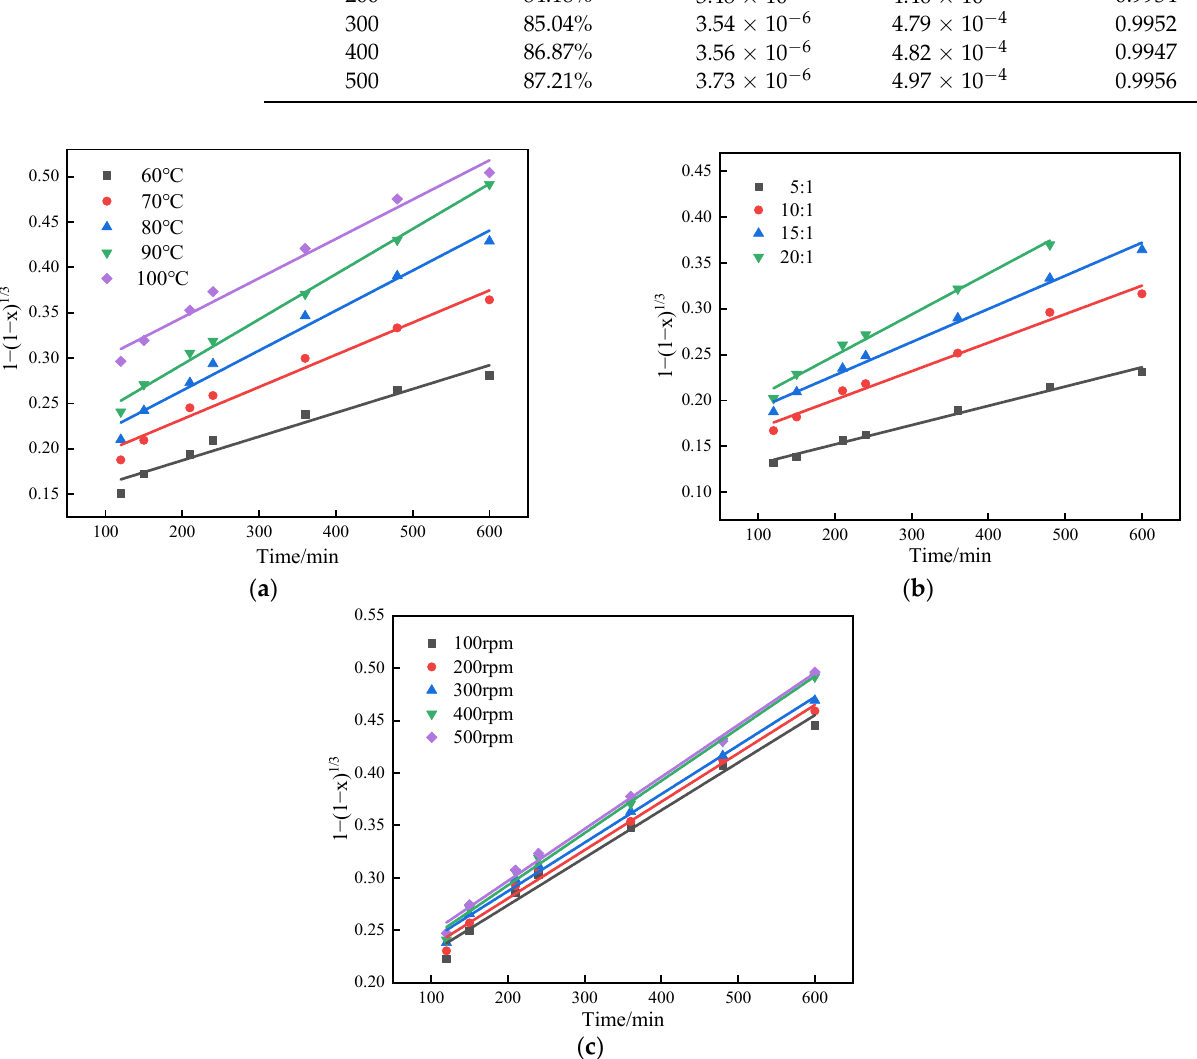
Figure 10. Kinetic reaction model under different leaching conditions: ( a ) leaching temperature, ( b ) liquid–solid ratio, and ( c ) stirring speed.